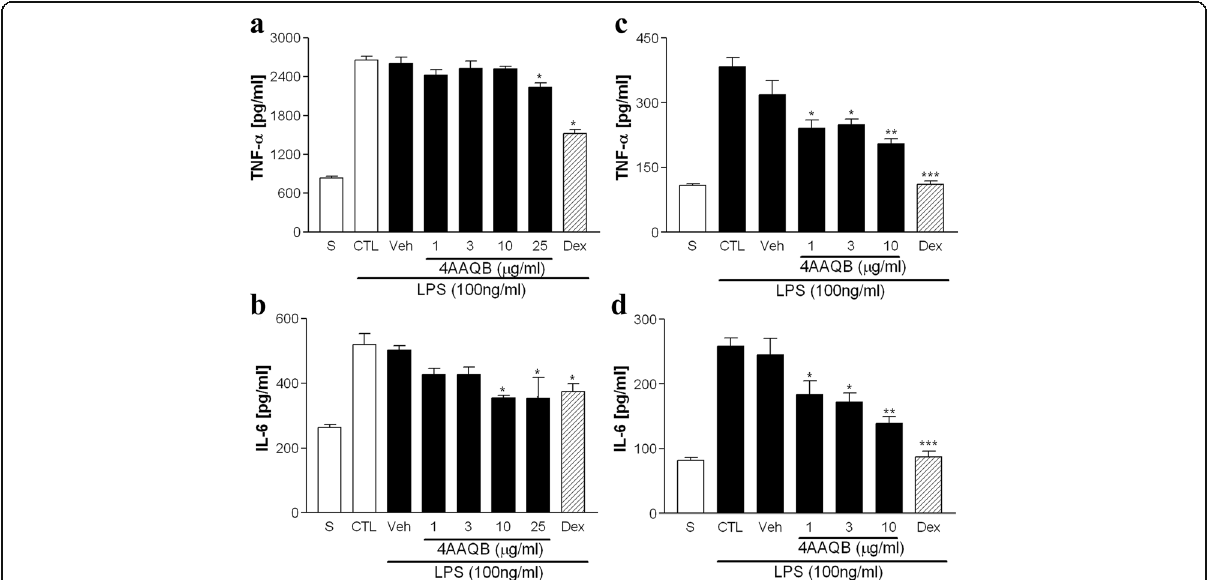
Fig. 2 Effect of 4AAQB on TNF α and IL-6 production in LPS-stimulated macrophages. RAW264.7 macrophages ( a , b ) or peritoneal macrophages ( c , d ) were pretreated with various concentrations of 4AAQB of dexamethasone (Dex, 10 μ M) for 30 min, and then activated with LPS (100 ng/ml) for 24 h. The TNF α and IL-6 concentrations were measured by ELISA kits. Results are showed as mean ± S.E.M of three independent experiments.